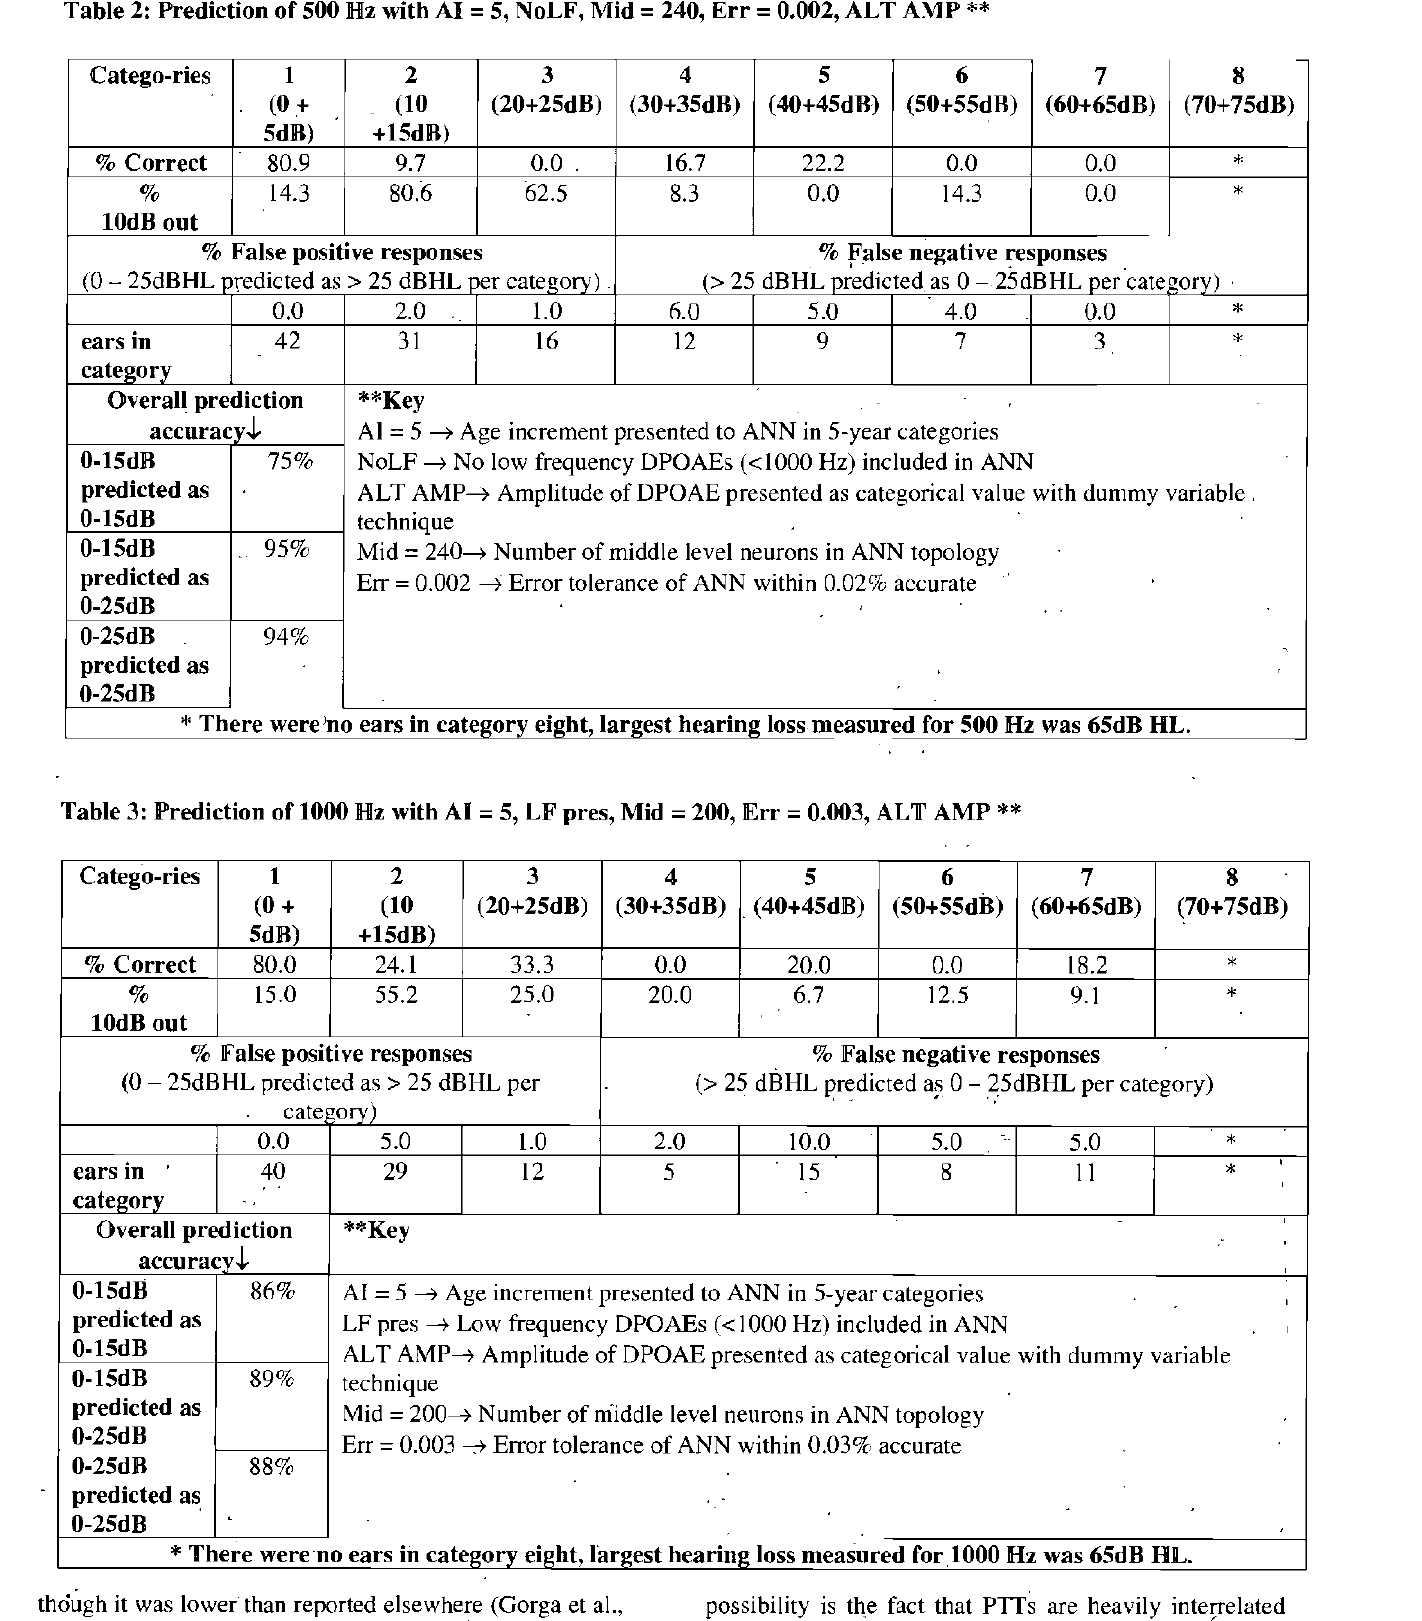
Table 2: Prediction of 500 Hz with Al = 5, NoLF, Mid = 240, Err = 0.002, ALT AMP **